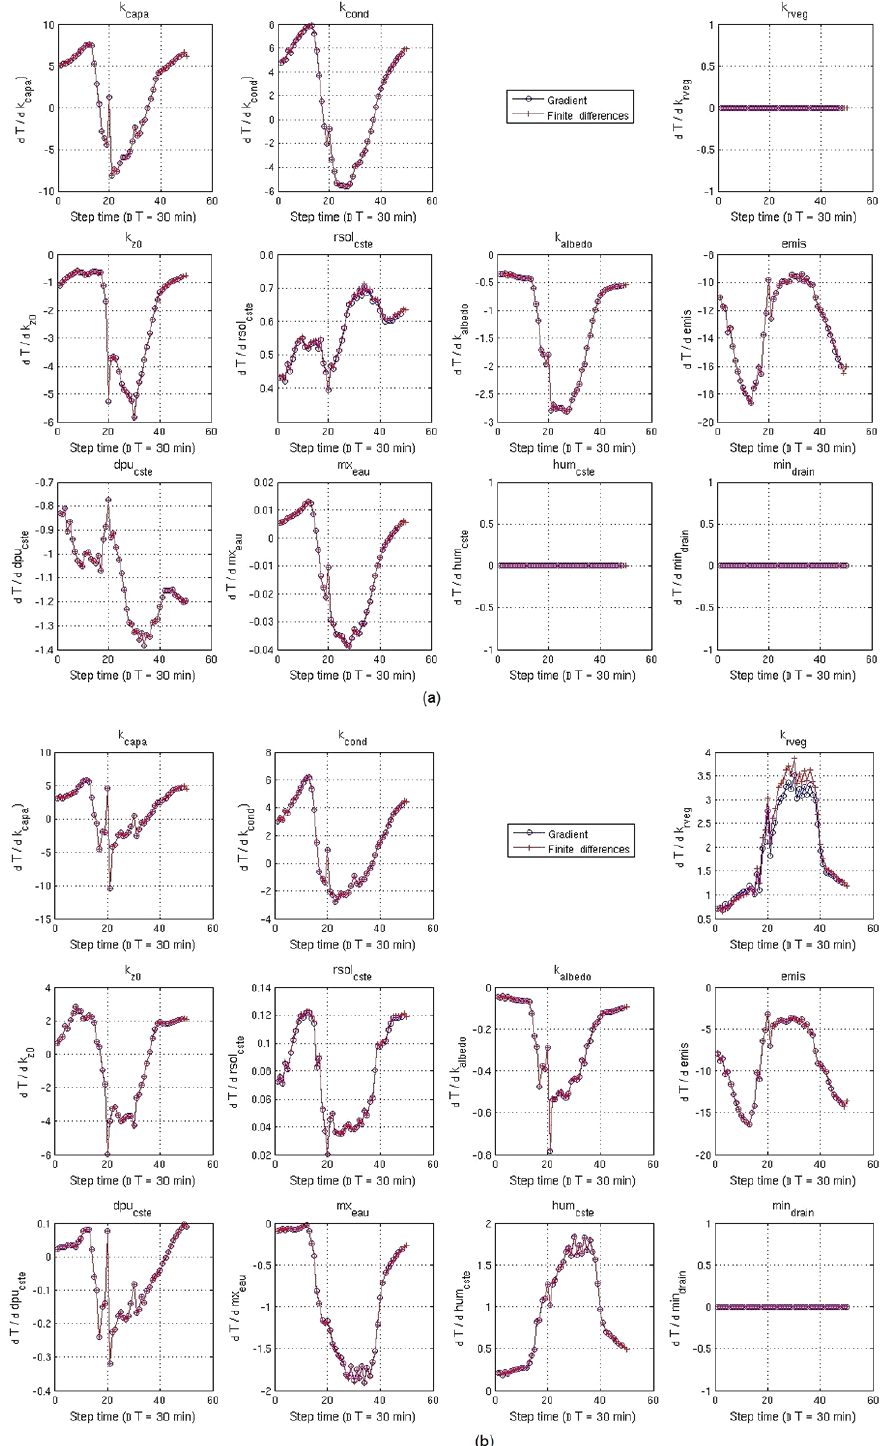
Figure 5. Comparisons for 11 February 2003 at the Kruger Park site of the sensitivities obtained for each control parameter with both the finite differences and the model gradients computed with the adjoint model. Sensitivity analysis results for PFT 1 are in (a) and for PFT 12 in (b) . The sensitivities were computed on the surface temperature. Blue curves represent the LST derivative with respect to each parameter given by the adjoint each half hour over a day. Red curves represent the LST derivative computed with a finite difference discretization of the